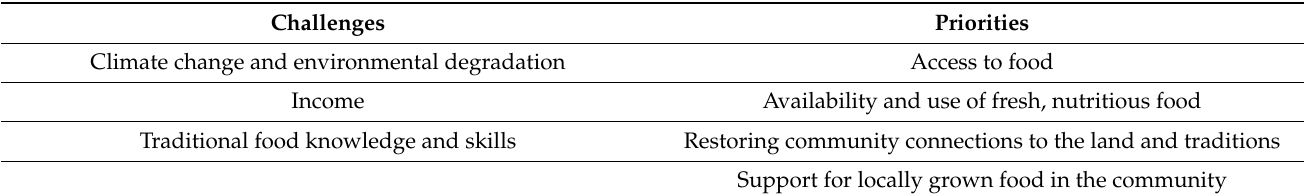
Table 1. Community perspectives of challenges and priorities to enhance food security and strengthen local food